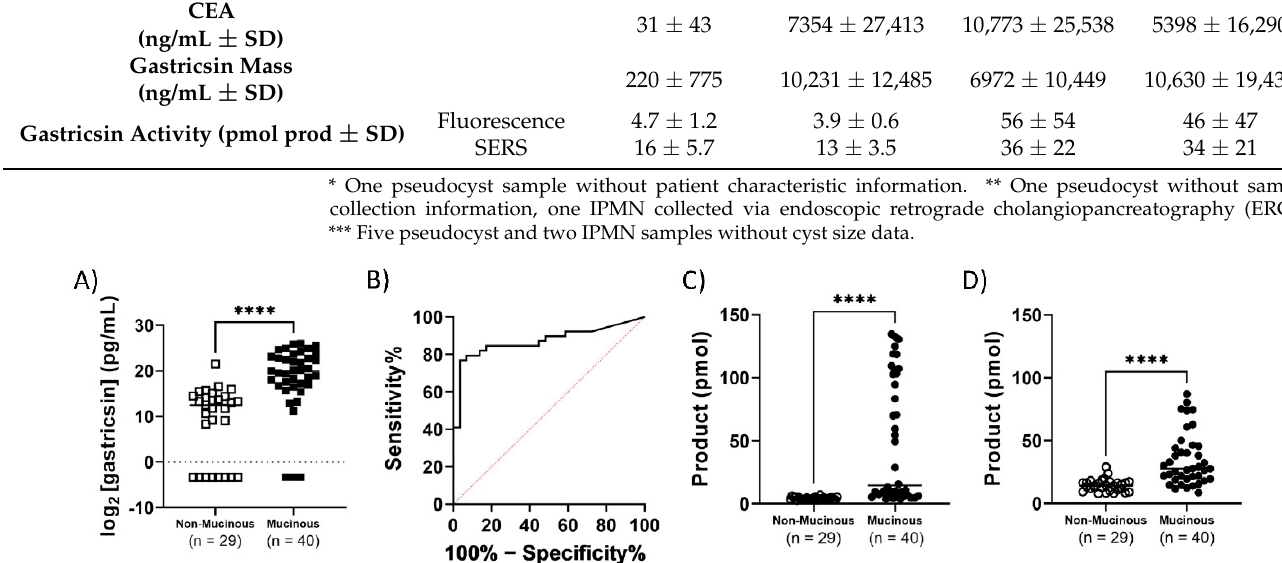
Figure 6. Clinical sample results from a retrospective cohort of 69 pancreatic cyst fluid samples with known clinical diagnoses. ( A ) The measured mass of pepsinogen C according to commercial ELISA kit. ( B ) ROC curve of ELISA measurement of pepsinogen C mass to distinguish mucinous from non- mucinous pancreatic cysts (AUC = 0.873, 95% CI 0.794–0.900). ( C ) Measured product formation cal- culated from fluorescence measurement of clinical samples. ( D ) Measured product formation cal- culated from SERS measurement of clinical samples. Sample measurements are paired and both ( C , D ) are divided into respective diagnosis category as indicated on the x-axis. ( E ) Correlation of product formation between SERS and fluorescence measurements from paired reaction samples. The grey area is the 95% confidence interval from a linear regression analysis with a slope = 0.348 and R 2 = 0.614. Every measurement represents a single reaction and sample. ( F ) ROC curve of clinical samples diagnosed according to the gastricsin activity assay using the product formation calculated from fluorescence (black, AUC = 0.936, 95% CI 0.882–0.990) or SERS (blue, AUC = 0.873, 95% CI 0.791–0.956), in comparison with clinical CEA measurement (red, AUC = 0.812, 95% CI 0.707–0.918) and a combination of all three (green, AUC = 0.950, 95% CI 0.900–1.000). **** = p < 0.0001 according to a Mann–Whitney test of significance. 4. Discussion These studies demonstrate a highly accurate magnetic bead-based protease assay platform with both fluorescence and SERS readouts. The work applies the newly devel- oped assay platform to measure gastricsin activity, which has been found enriched in mu- cinous pancreatic cyst fluids collected through fine needle aspiration, either pre- or post- surgical resection as indicated in Table 1. The gastricsin and CEA analyses can assist clin- ical decisions regarding the potential risk of cysts to develop into pancreatic cancer. The first step for clinical decision-making is to address whether they are dealing with a benign, non-mucinous, or potentially cancerous, mucinous cyst. Mucinous cysts are significantly more likely to become cancerous but surgical pancreatic resection can prevent this near- universal deadly outcome [10]. As such, accurate diagnosis, aided by the assays, will be useful in determining the risk of the patient developing a pancreatic cancer. The assay uses a peptide substrate that is selectively cleaved by gastricsin which aims to prevent false negatives. Notably, the presence of pepsin, which is structurally similar to gastricsin, can give a false response in the assays. This situation can be remedied by addition of pepstatin, which selectively inhibits pepsin. While pepsin is not a major con-